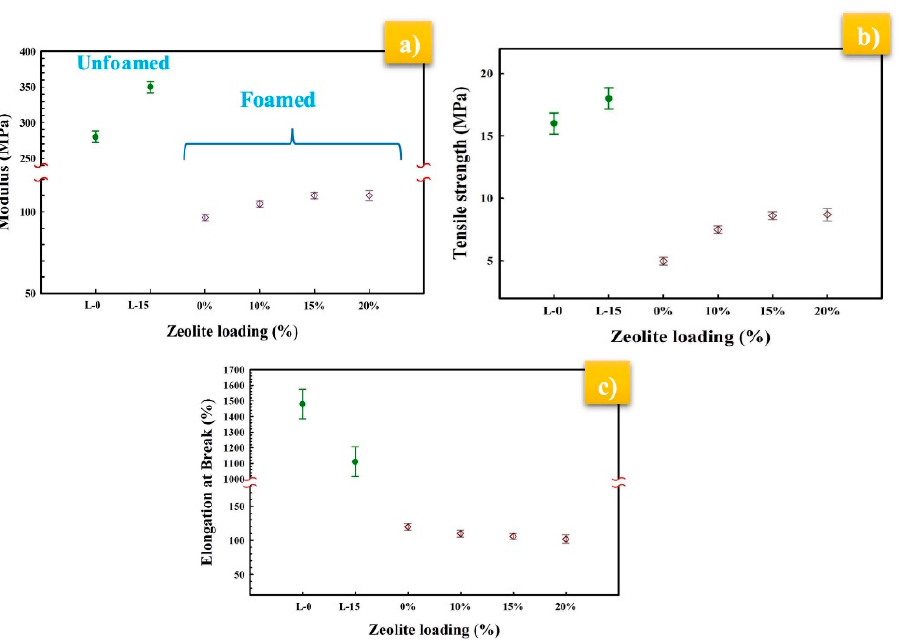
Figure 17. ( a ) Young’s modulus, ( b ) tensile strength, and ( c ) elongation at break of the foamed and unfoamed hollow fibers at different zeolite loading.